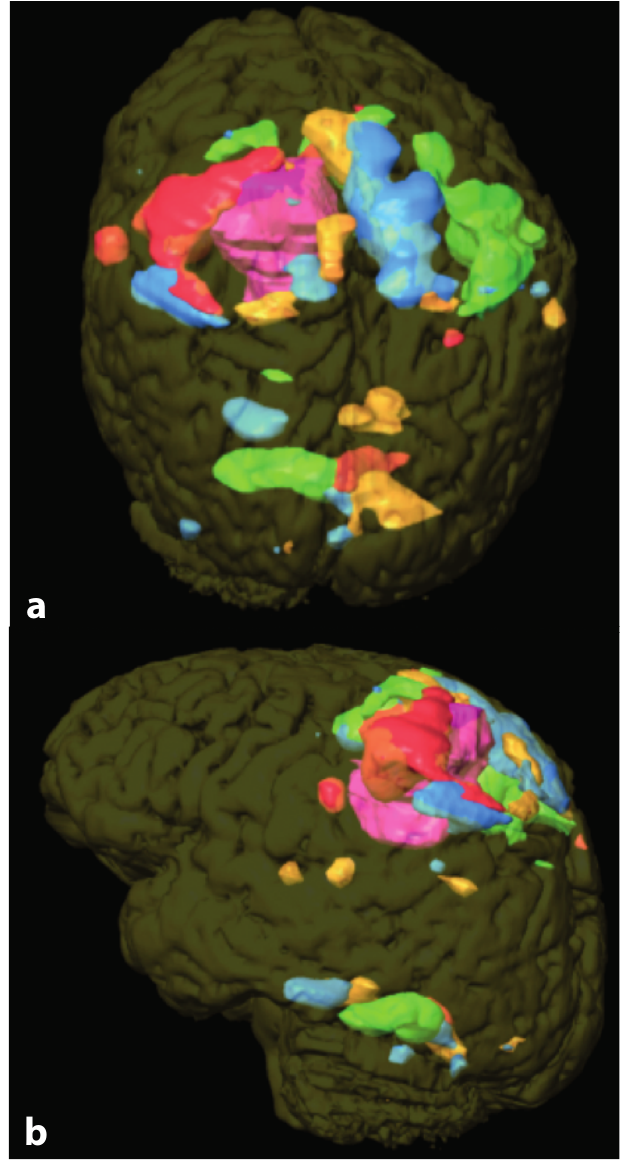
Fig. 1. Rendered brain surface showing the tumour (pink) and fMRI motor regions in (a) oblique-posterior, and (b) lateral views. Red is right hand/wrist/ forearm; blue is left hand/wrist/forearm; orange is right foot/toes; green is left foot/toes. Note the contralateral activation in the cerebellum.